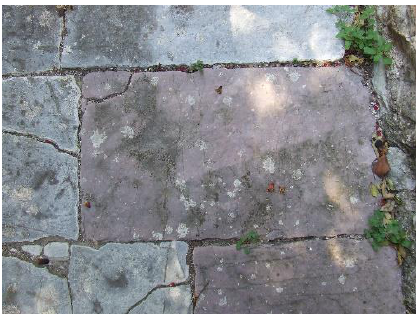
Figure 19. Verige and Kamenare quarries contain gray and red plate stones. Figure 19. Less regular shaped blocks on the lateral façade from Strp and Lipci quarries.